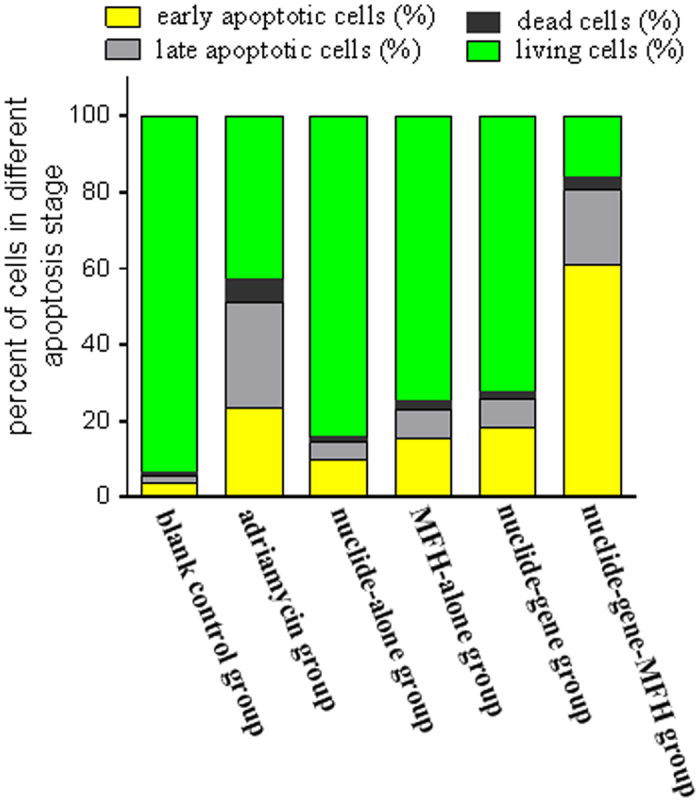
Flow cytometric analysis for apoptosis of HepG2 cells with different treatment (%).